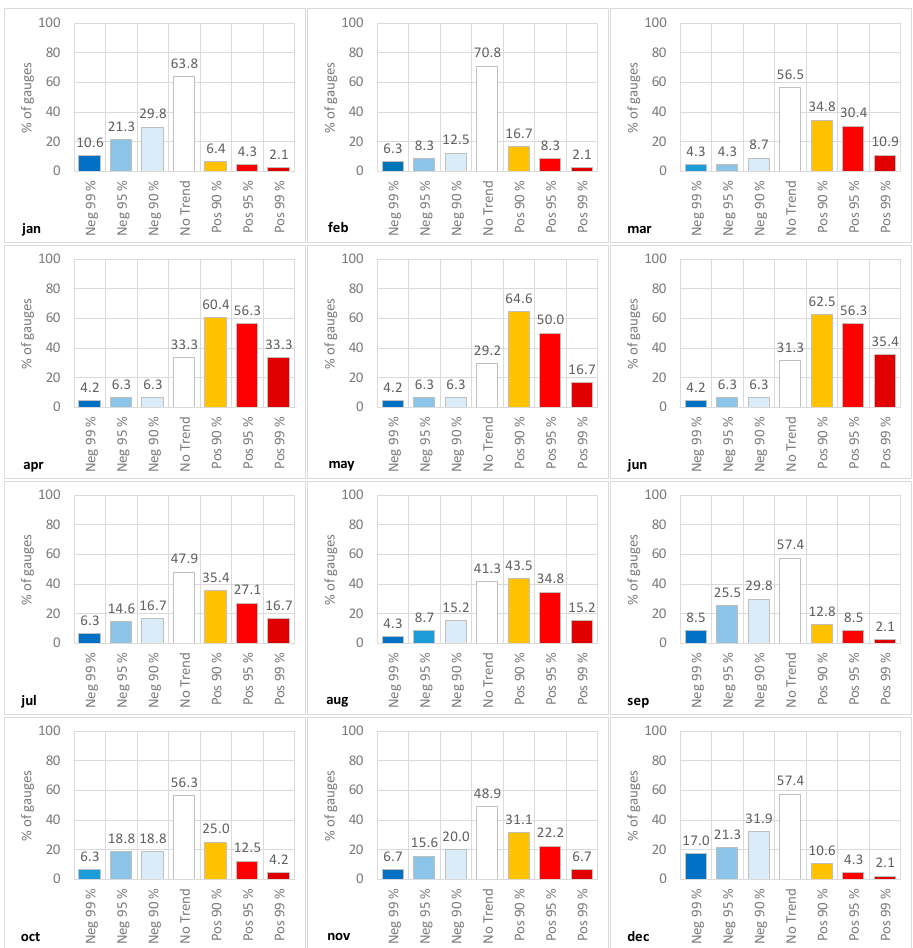
Figure 4. Percentages of maximum temperature series presenting positive or negative trends.